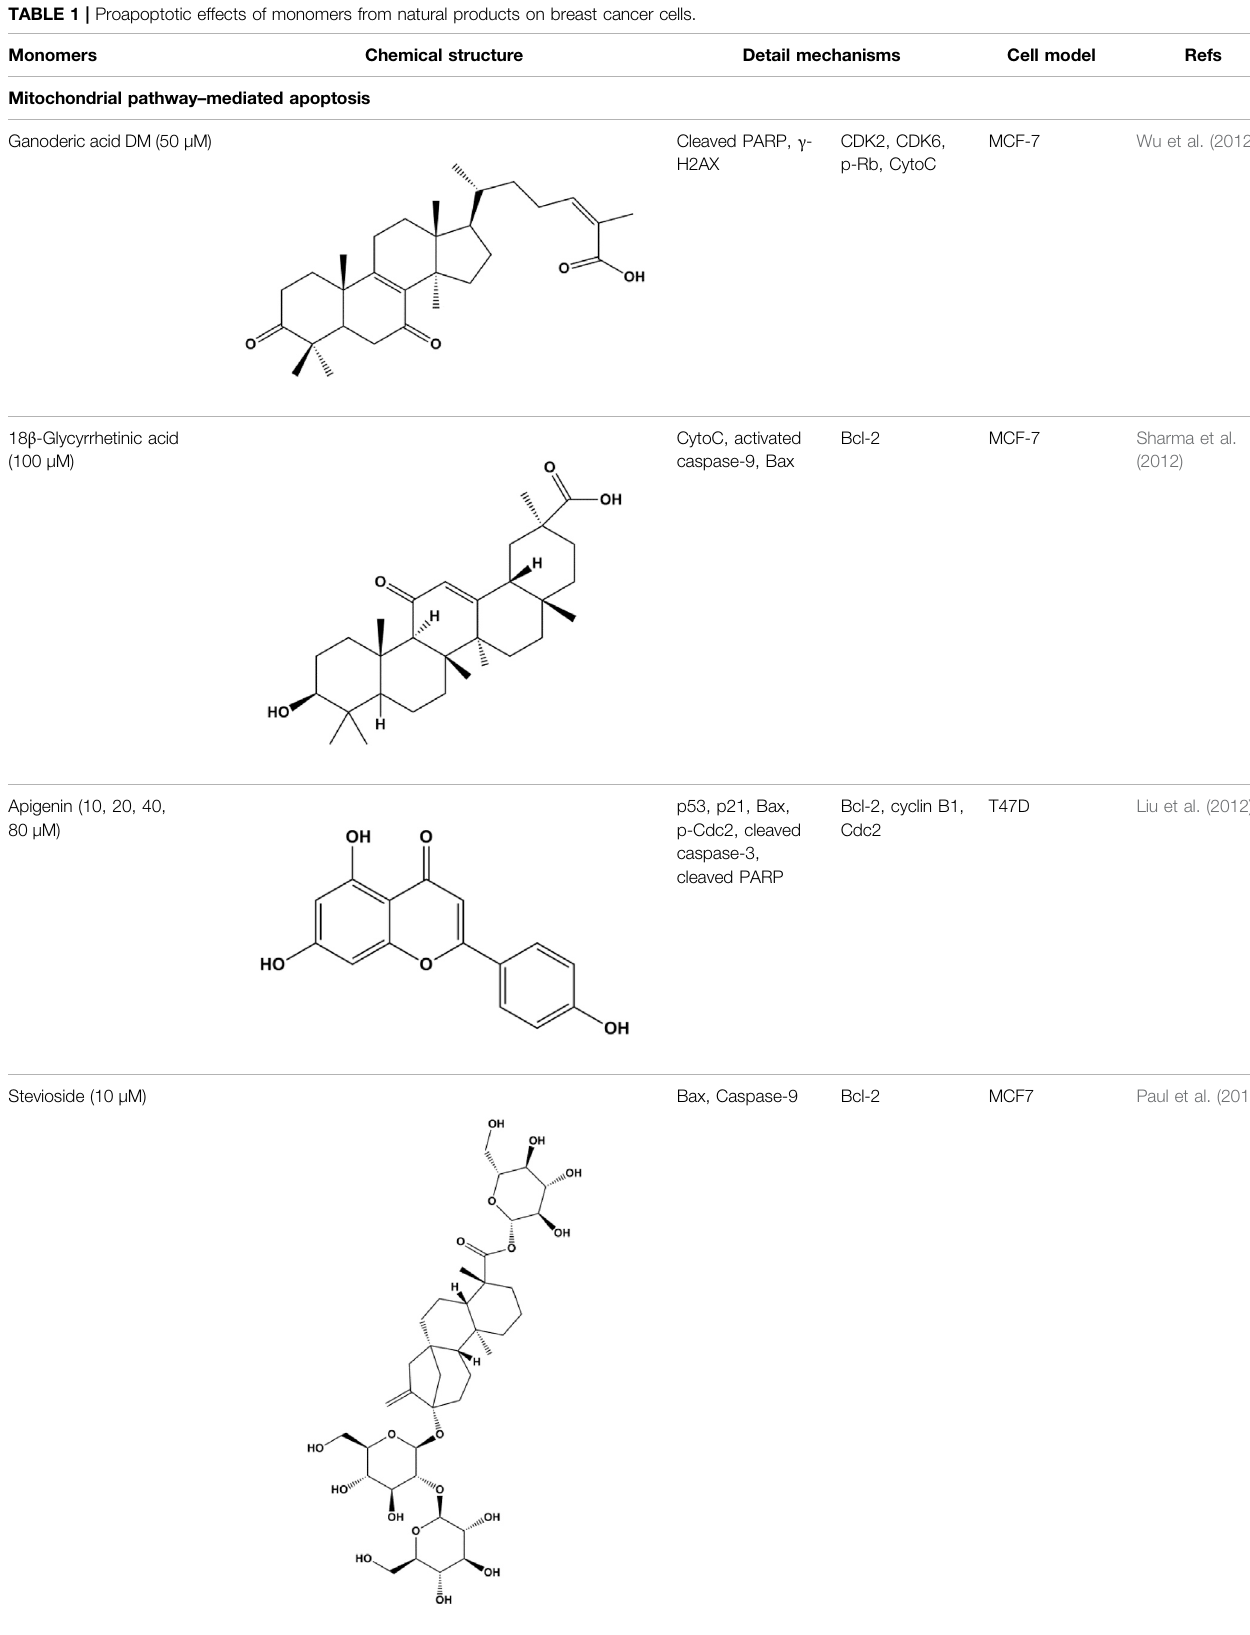
TABLE 1 | Proapoptotic effects of monomers from natural products on breast cancer